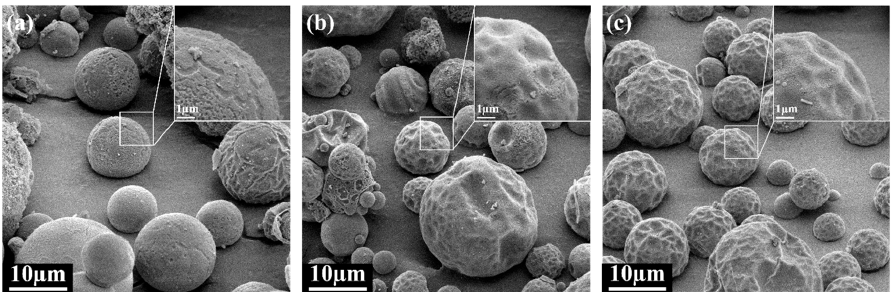
Figure 2. Scanning electron microscopy (SEM) images of spray dried ( a ) 58S, ( b ) 68S, and ( c ) 76S BG powders with insets of their surfaces captured at higher magnification.